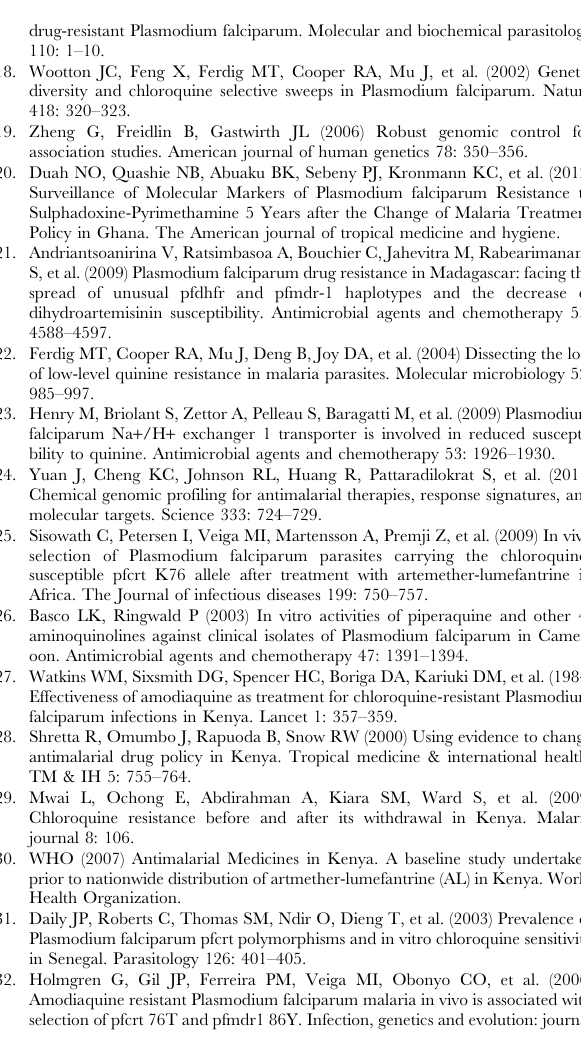
Table S3 Variants detected in pfnhe . Column ‘N’ is the number of samples in this study carrying that allele. Table S4 Amino acid haplotypes of variants in pfcrt . Column ‘N’ is the number of samples in this study represented by that haplotype. Table S5 Pairwise drug correlations. Table S6 European Nucleotide Archive accession numbers and corresponding phenotypic data for the 35 samples used in this study. Drug abbreviations and concentration units are described in table